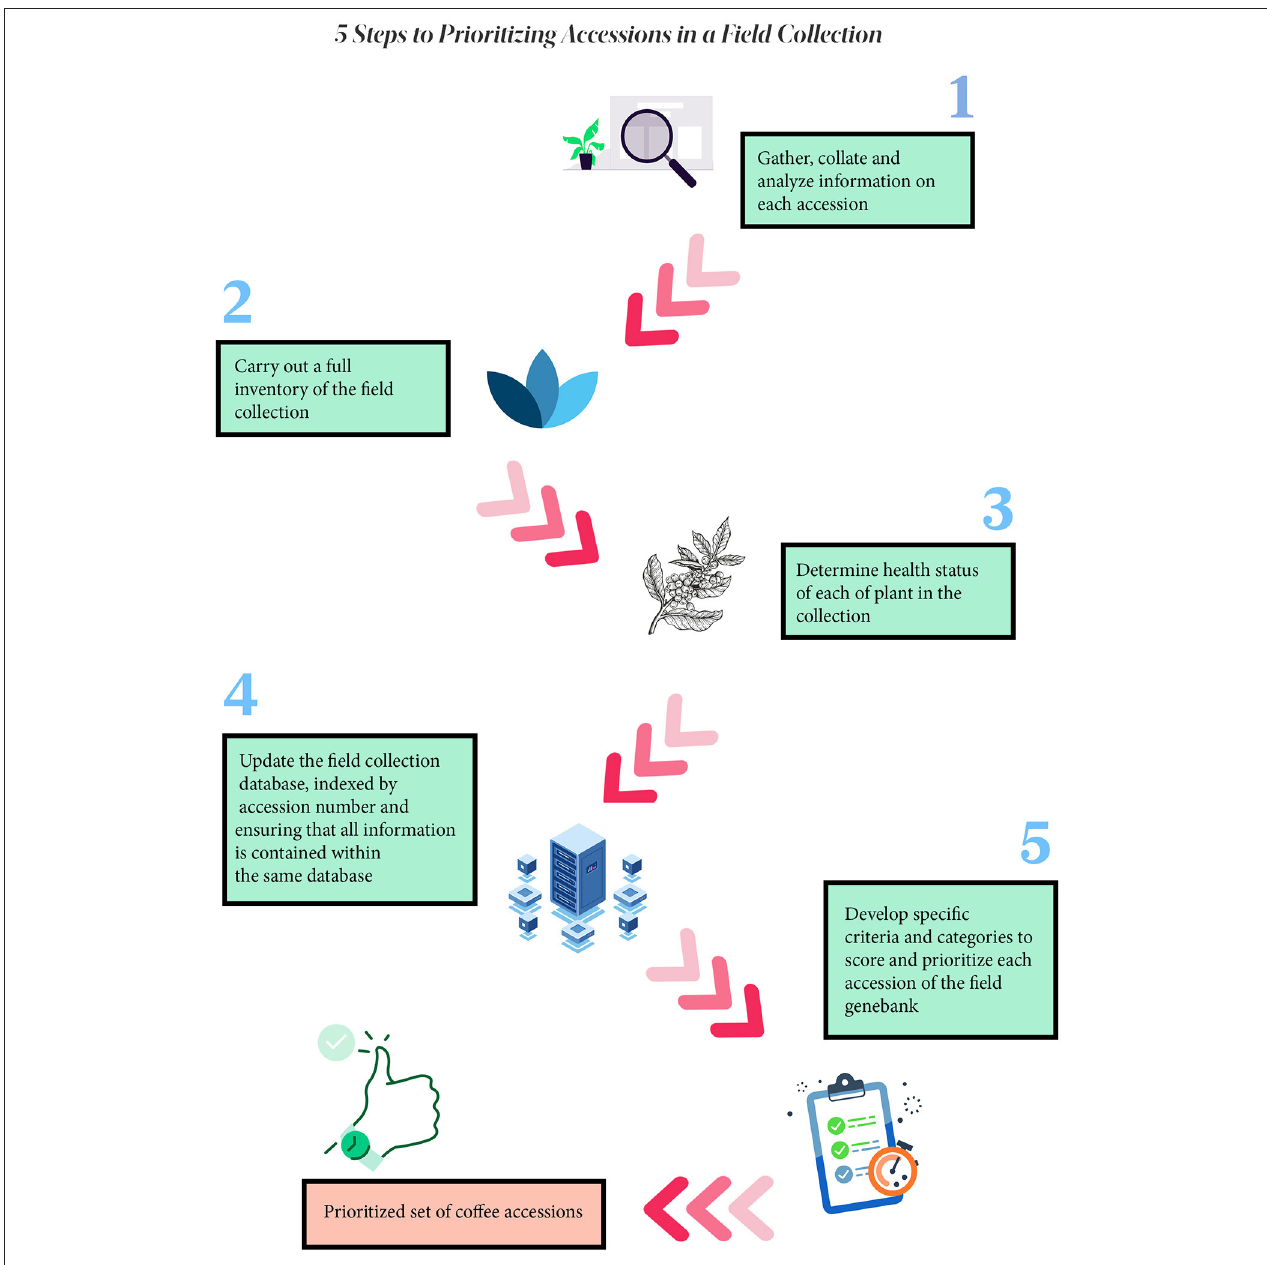
FIGURE 1 | Five steps to prioritizing accessions in a field